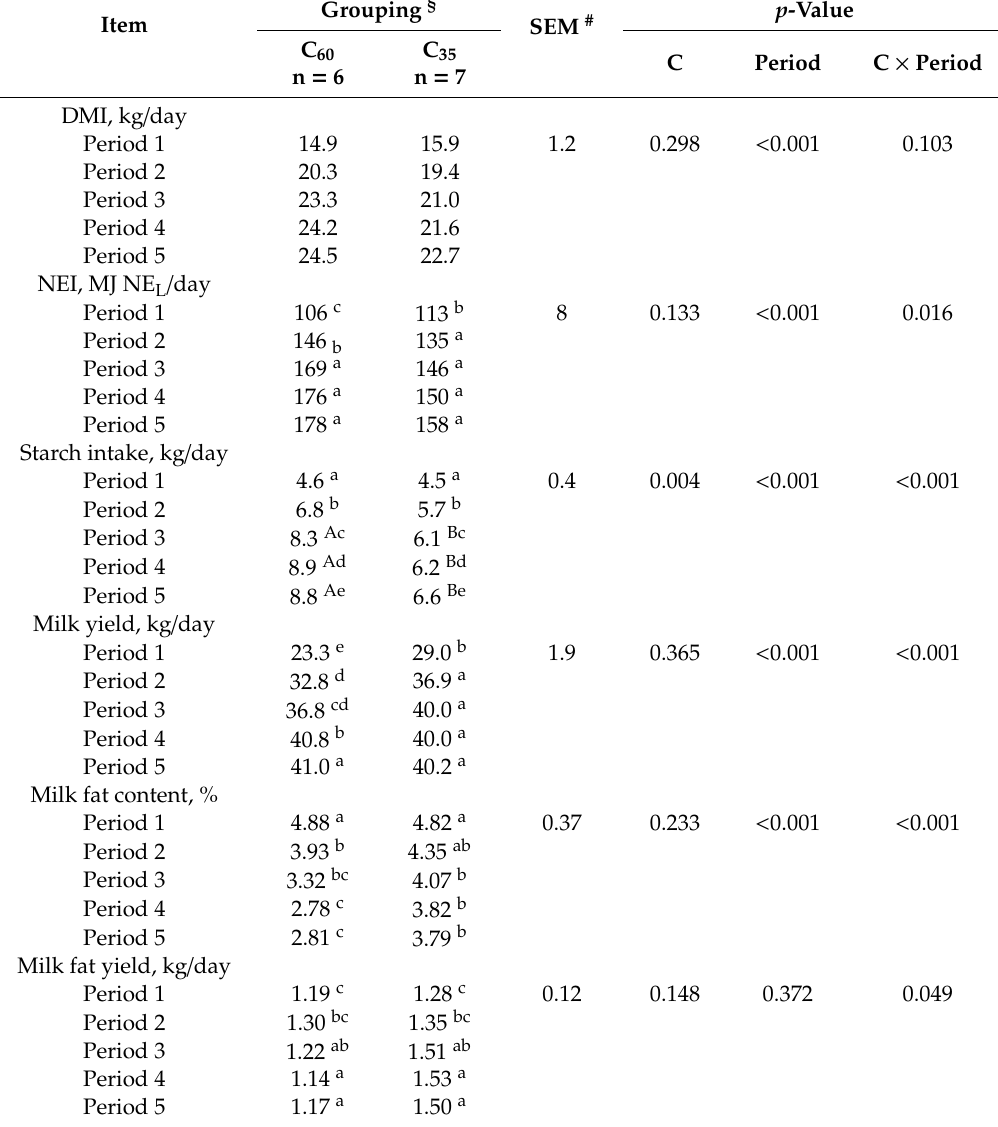
Table A1. E ff ects of concentrate feed proportion in the diet (C) and period on dry matter intake (DMI), net energy intake (NEI), milk yield, energy corrected milk (ECM) and milk components during period 1 (weeks 1–2 postpartum), period 2 (weeks 3–4 postpartum), period 3 (weeks 5–6 postpartum), period